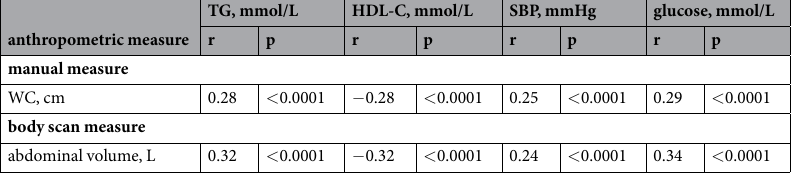
Table 2. Spearman partial correlation of manually measured waist circumference and body scanner-based abdominal volume with parameters of the Metabolic Syndrome 1 , total (N = 411). HDL-C, high-density lipoprotein cholesterol; SBP, systolic blood pressure; TG, triglycerides; WC, waist circumference 1 Model adjusted for adjusted for age, sex, and body height (manual